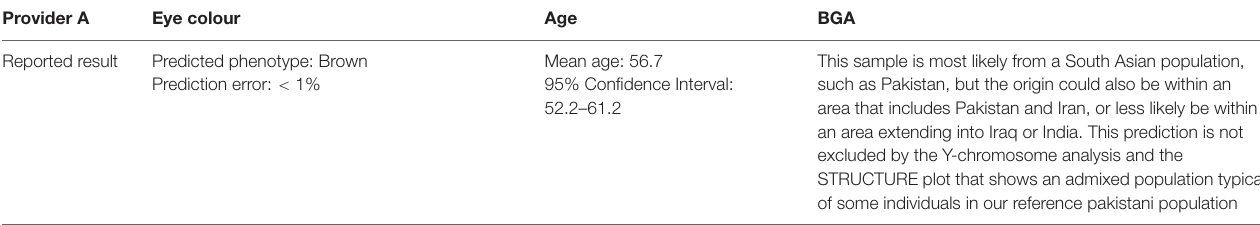
TABLE 4 | Provider A reporting style for eye colour, age, and BGA prediction. Provider A Eye colour Reported